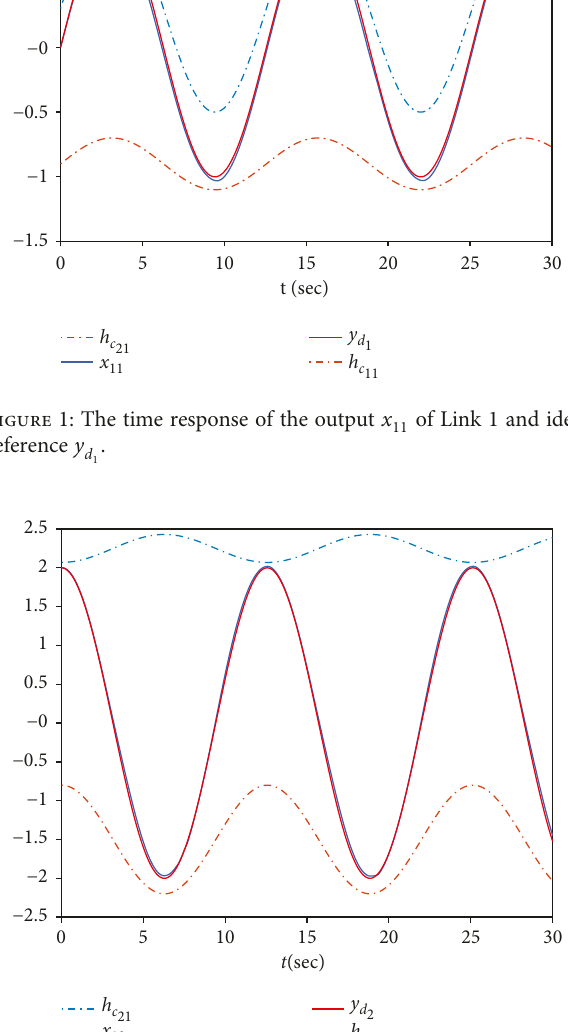
Figure 2: The time response of the output x . reference y d 2